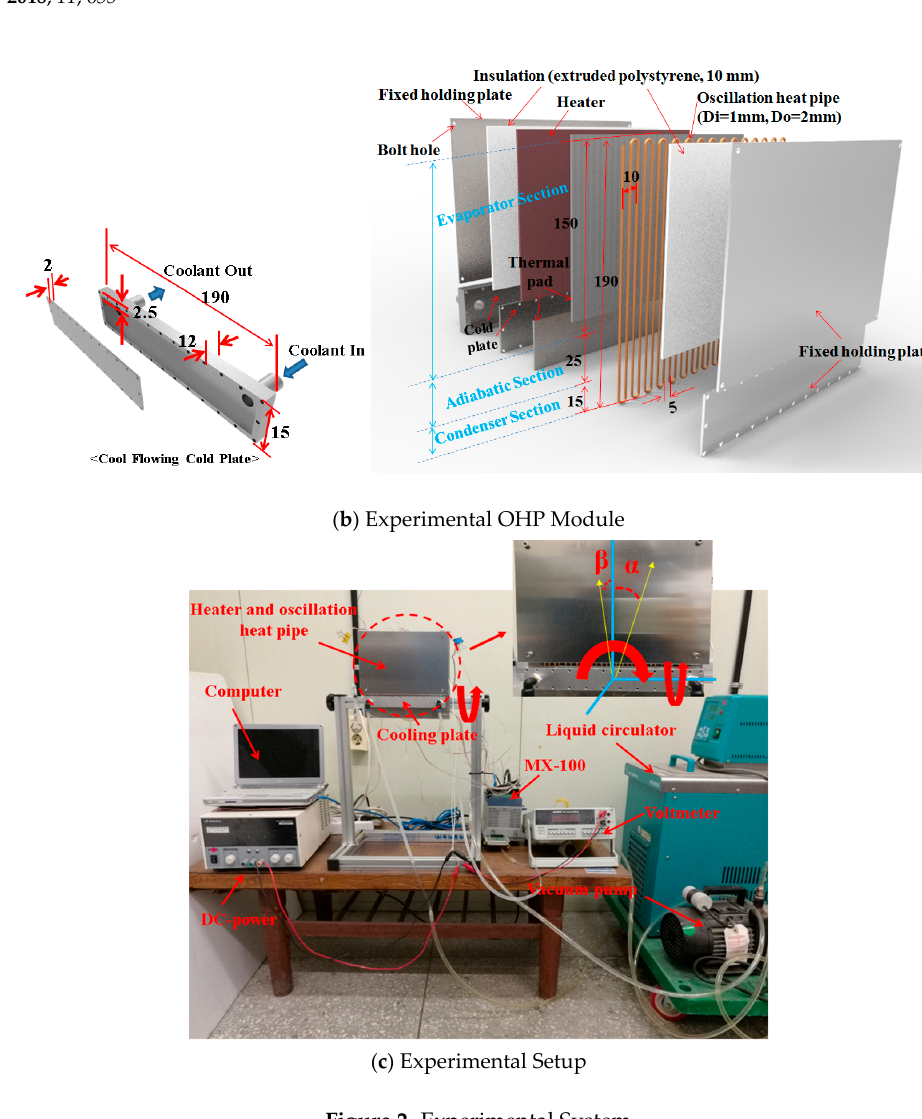
Figure 2. Experimental System.